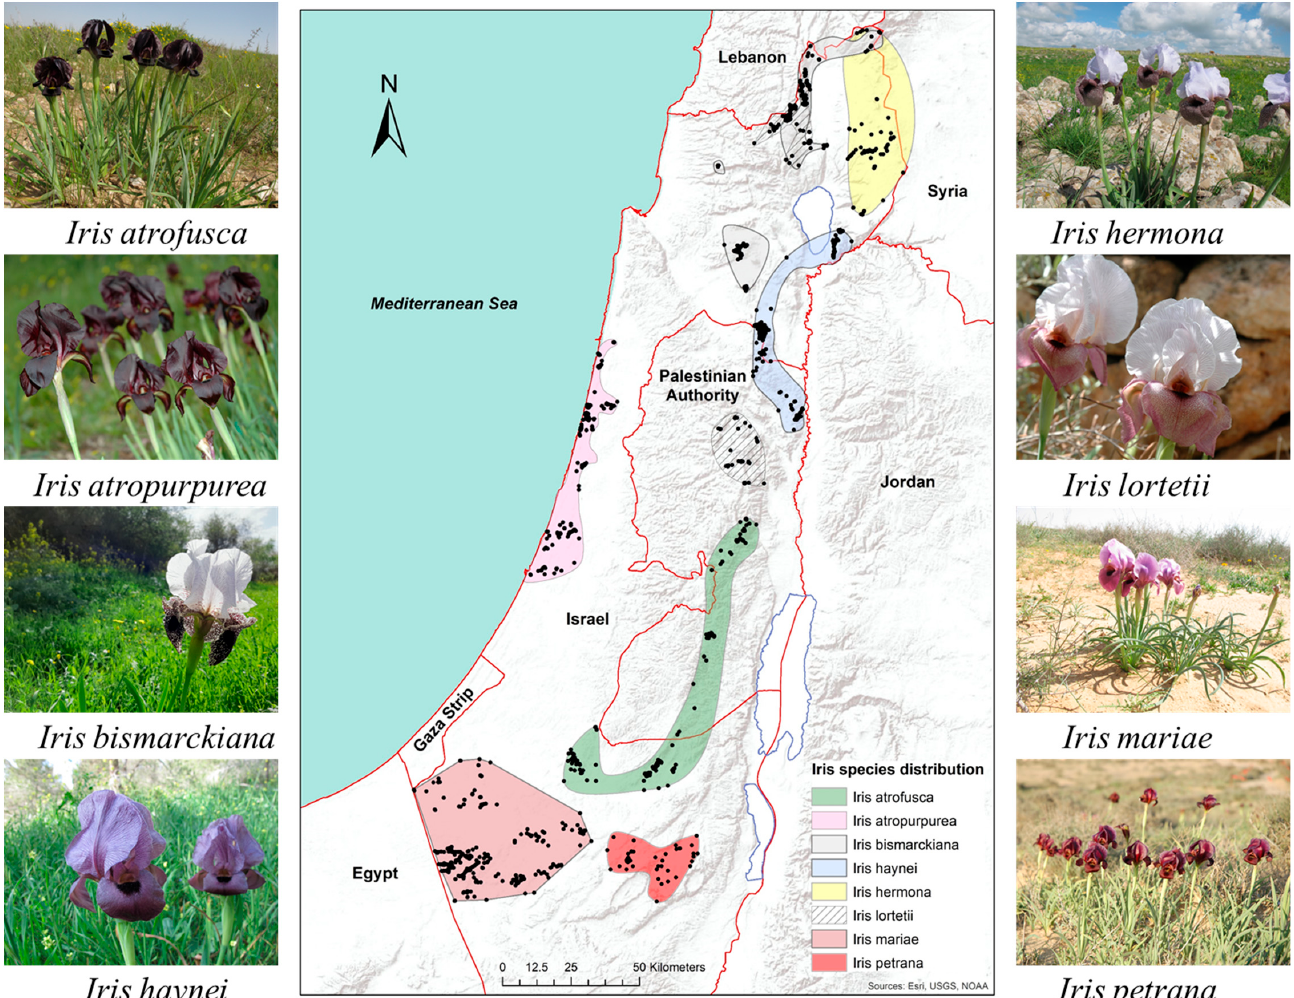
Figure 1. Distribution of the eight species of royal irises in Israel and Palestine. Points are all confirmed observations, starting in the early 1900s, including populations extinct due to human dis- turbances.